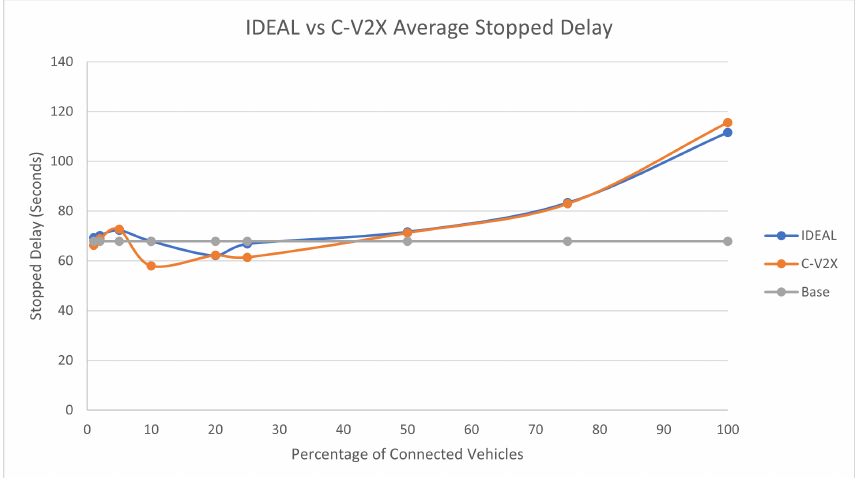
Figure 9. Average network-wide Stopped Delay of Energy-Efficient dynamic routing application using IDEAL and C-V2X communication on LA road network with traffic demand of scale factor